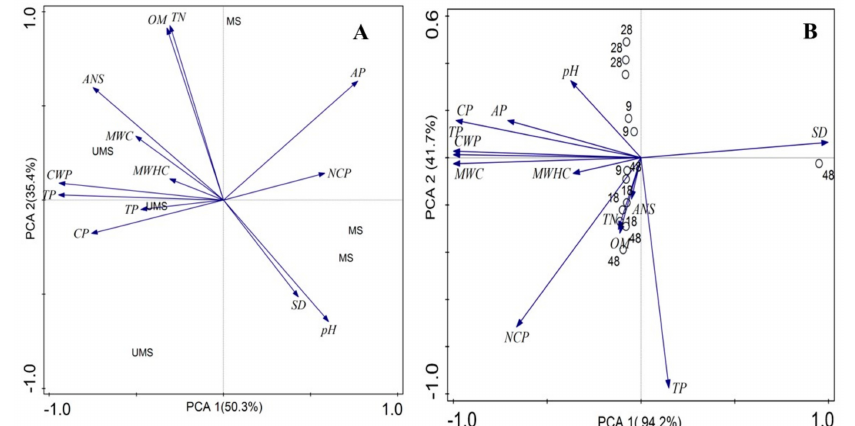
Figure 4. ( A , B ). Principal component analysis (PCA) of soil physical properties from di ff erent stand age groups and management treatments in P. massoniana plantations. Note: Maximum water capacity (MWC); maximum water holding capacity (MWHC); capillary water capacity (CWP); capillary porosity (CP); noncapillary porosity (NCP); total porosity (TPo); soil density (SD); soil pH (pH); total phosphorus (TP); organic matter (OM); total nitrogen (TN); available phosphorus (AP); available N (AN).